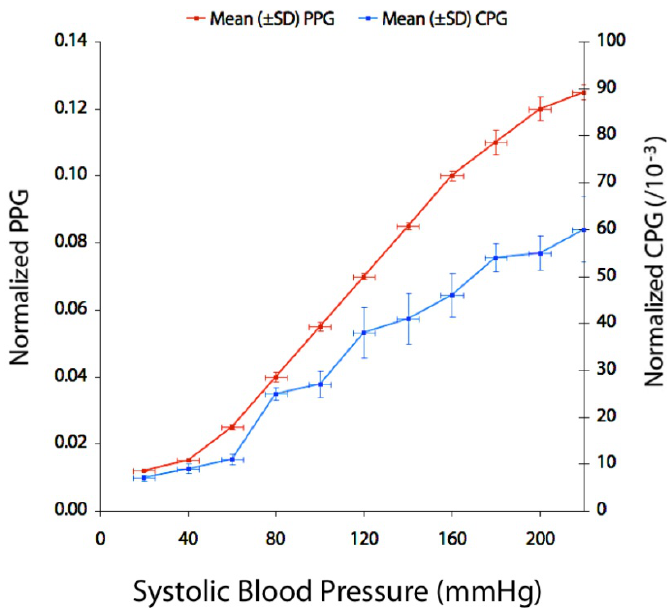
Figure 8. Graph of mean (±SD) normalized PPG amplitude (left y -axis) and mean (±SD) normalized CPG amplitude plotted against systolic